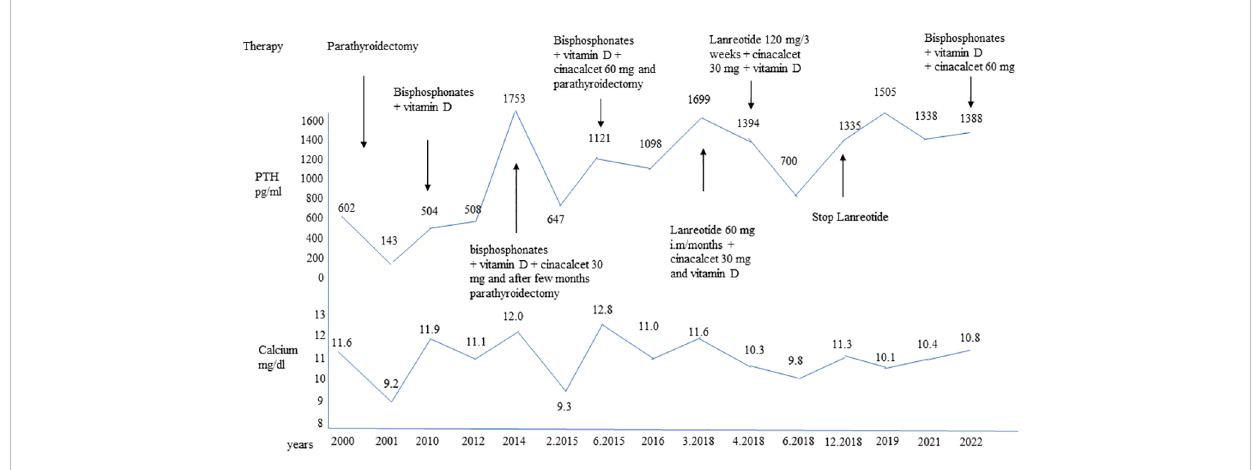
FIGURE 2 Trend of calcium and PHT values and their respective